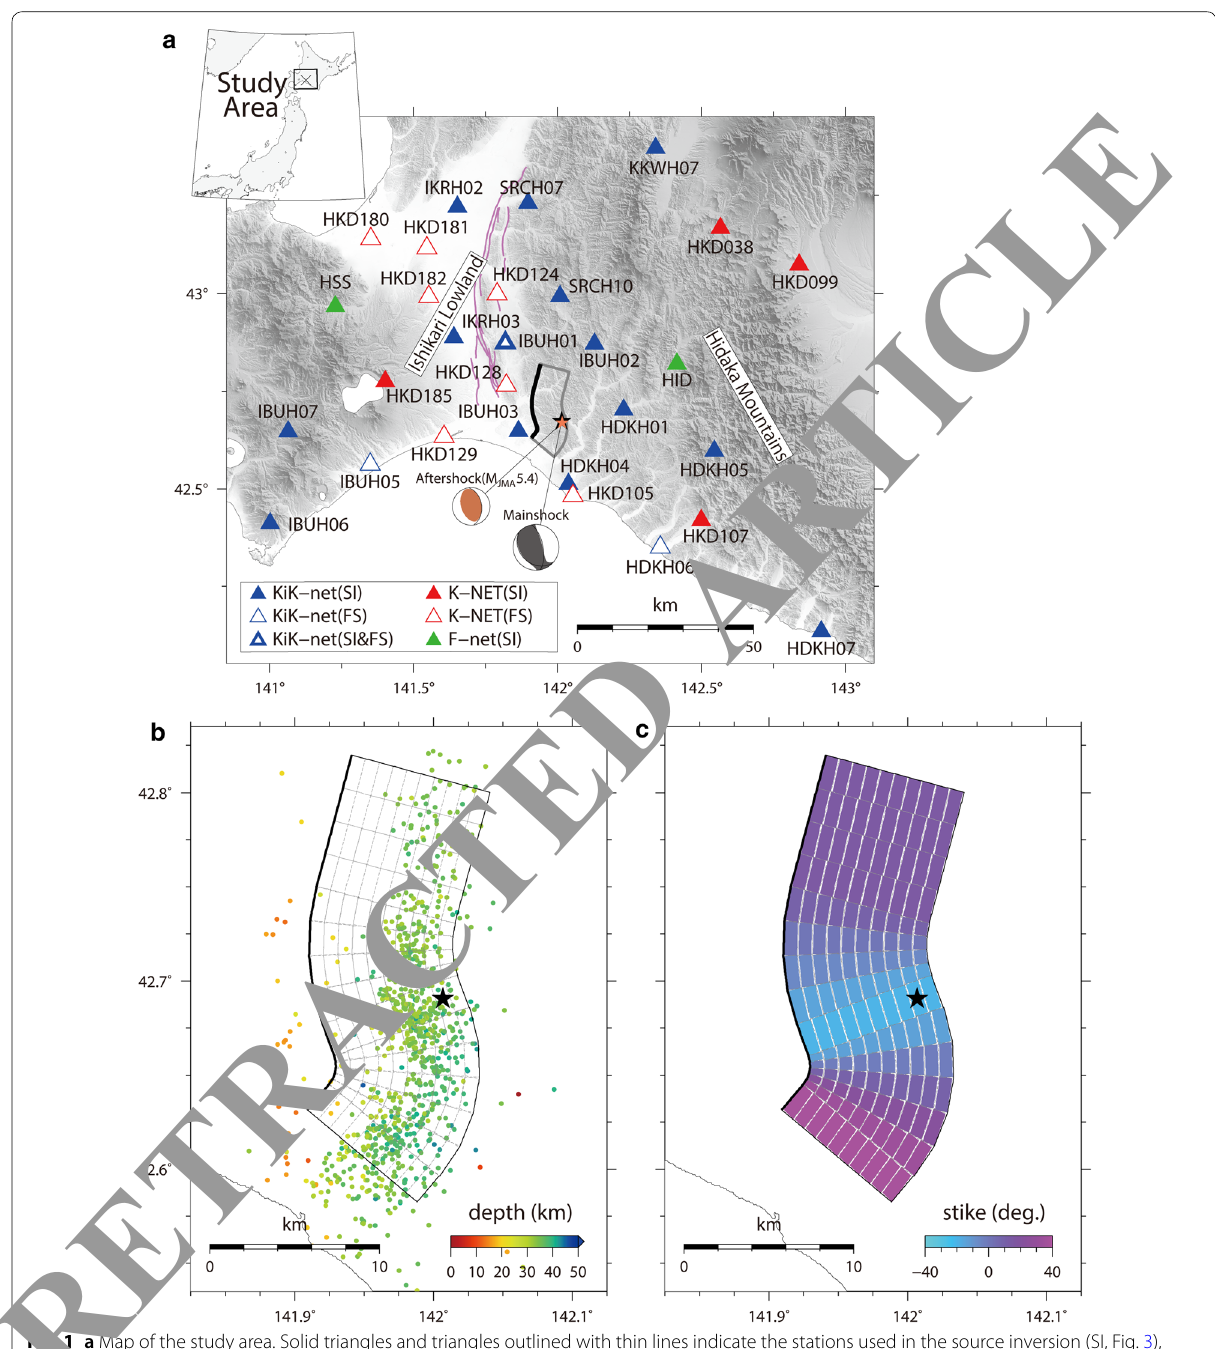
Fig. 1 a Map of the study area. Solid triangles and triangles outlined with thin lines indicate the stations used in the source inversion (SI, Fig. 3), and the stations used to compare observation and forward ground-motion simulation (FS, Fig. 4), respectively. Triangles outlined with thick lines indicate the stations used in both analyses (SI and FS). The color of the triangles indicates the observation network: blue, red, and green are KiK-net, K-NET, and F-net, respectively. Black and coral stars indicate the epicenters of the 2018 Hokkaido Eastern Iburi earthquake and the aftershock ( M JMA 5.4) at 6:11 JST on September 6, 2018, respectively. Focal mechanisms refer to the F-net moment tensor solutions. The black line denotes the outline of the curved fault model used in the source inversion. Magenta lines denote the surface traces of the active fault zone along the eastern margin of the Ishikari lowland (AIST 2007). b Map view of the curved fault model. Circles denote hypocenters of the aftershocks ( M mainshock. The color of the circles indicates the event depth. c Distribution of strike angle on the curved fault